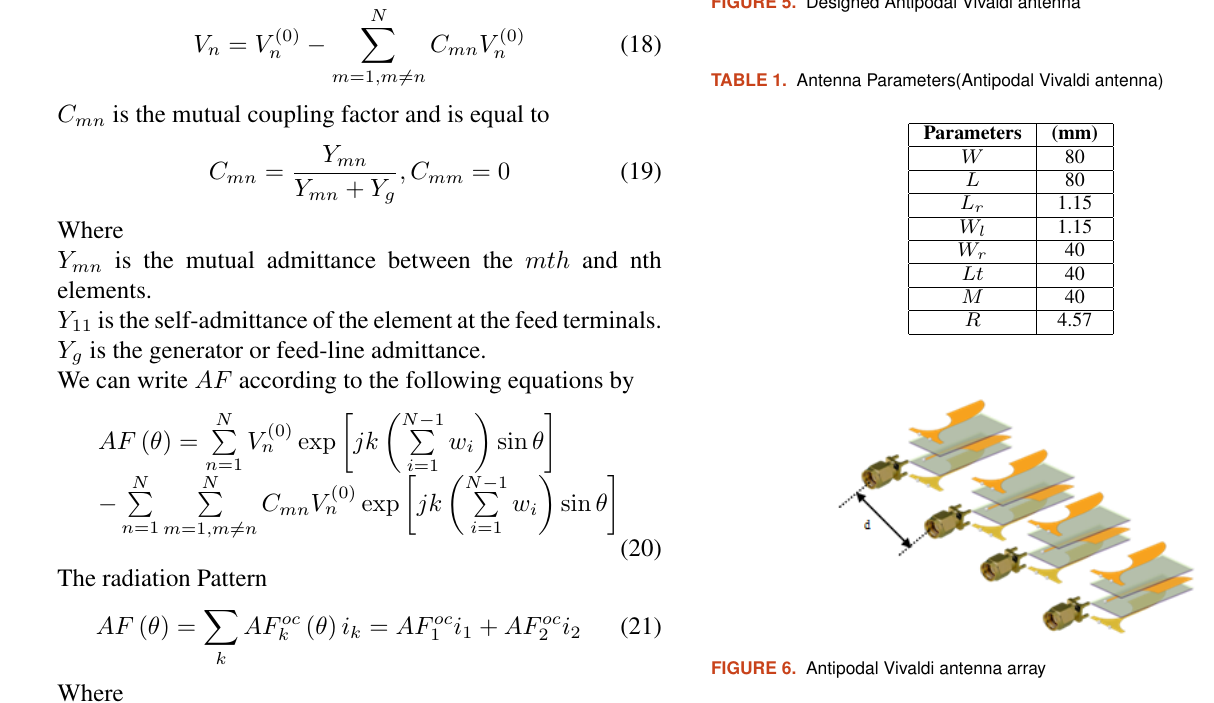
FIGURE 5. Designed Antipodal Vivaldi antenna